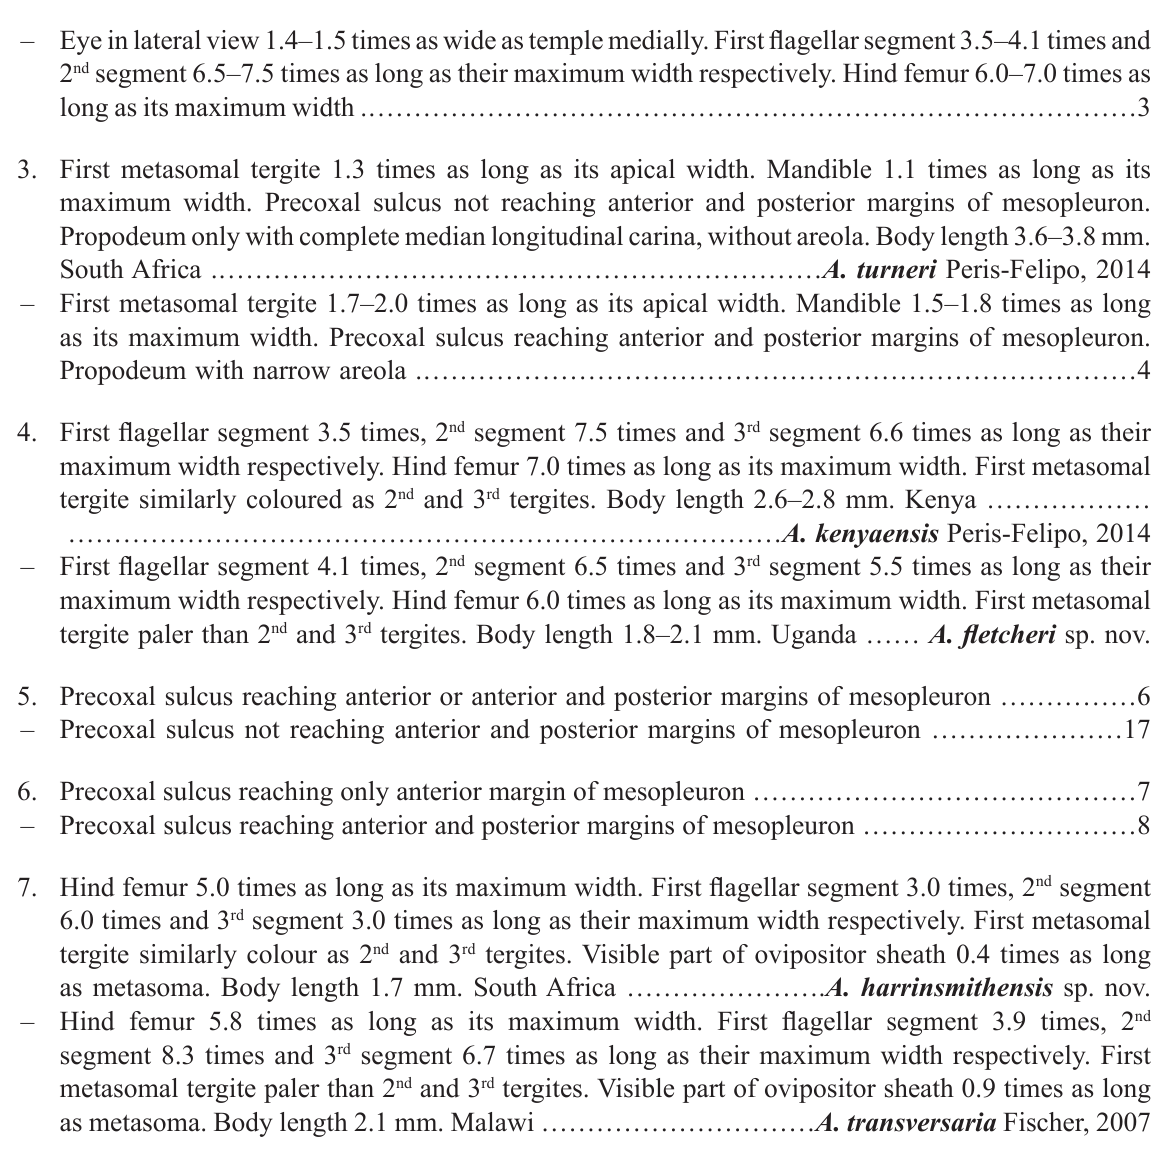
as its apical width and similarly colour as 2 nd and 3 rd tergites. First flagellar segment 3.0 times as long as its maximum width. Head in dorsal view 1.4 times as wide as long. Propodeum with areola. Visible part of ovipositor sheath as long as metasoma. Body length 2.0–2.1 mm. South Hind femur 5.0 times as long as its maximum width. First metasomal tergite 1.8 times as long as its apical width, paler than 2 nd and 3 rd tergites. First flagellar segment 3.4 times as long as its maximum width. Head in dorsal view 1.8 times as wide as long. Propodeum without